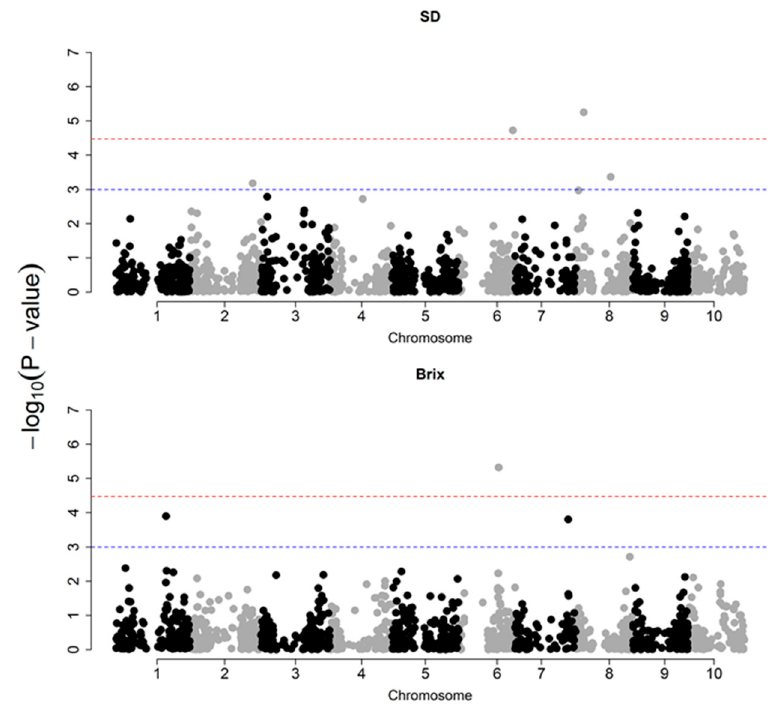
Figure 7. Manhattan plots showing p values and marker–trait associations for SD and Brix. Red and blue horizontal lines indicate thresholds for significant marker–trait associations after Bonferroni correction ( p < 3.32 × 10 − 5 , 0.05/ N ) and weak associations ( p < 1 × 10 − 3 ).